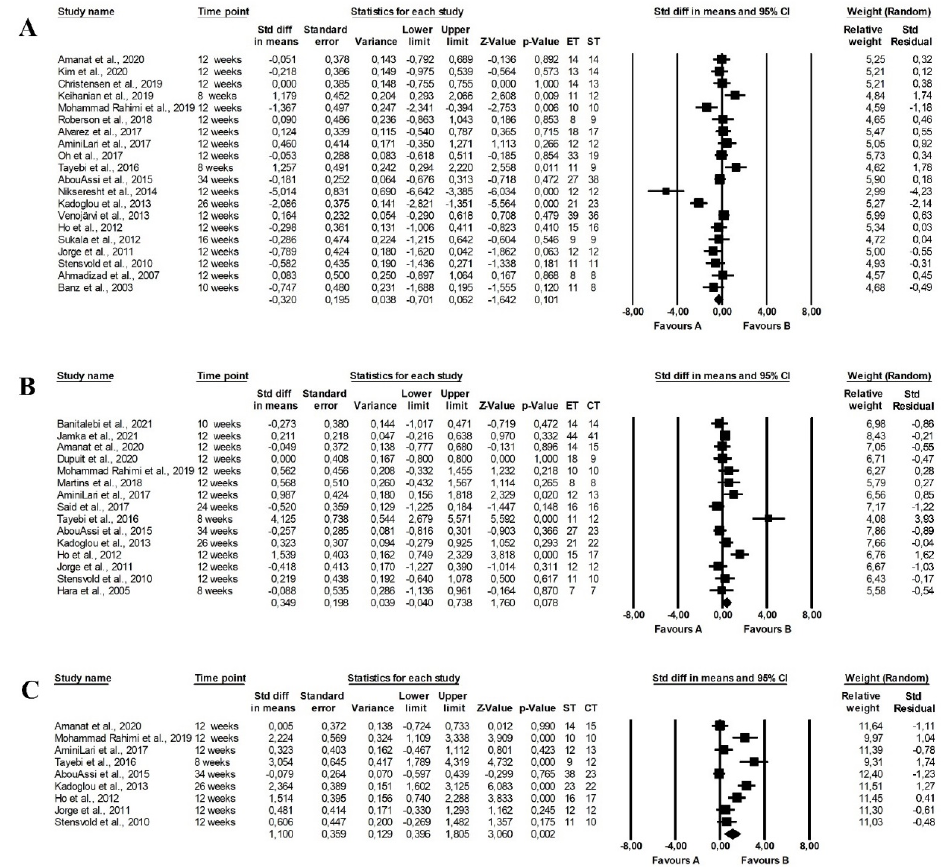
Figure 2. Forest plots of the effect of training programmes on glucose levels: ( A ) endurance (favours A) vs. strength (favours B) training (random model) [16,20,41,43–46,49–51,53,58,63,65– 67,71,73]; ( B ) endurance (favours A) vs. endurance-strength (favours B) training (random model) [20,22,37–39,41,46,48,51,54,58,63,66,69,72]; ( C ) strength (favours A) vs. endurance-strength training; ET—endurance training; ST—strength training; Std—standard; Std diff—standard